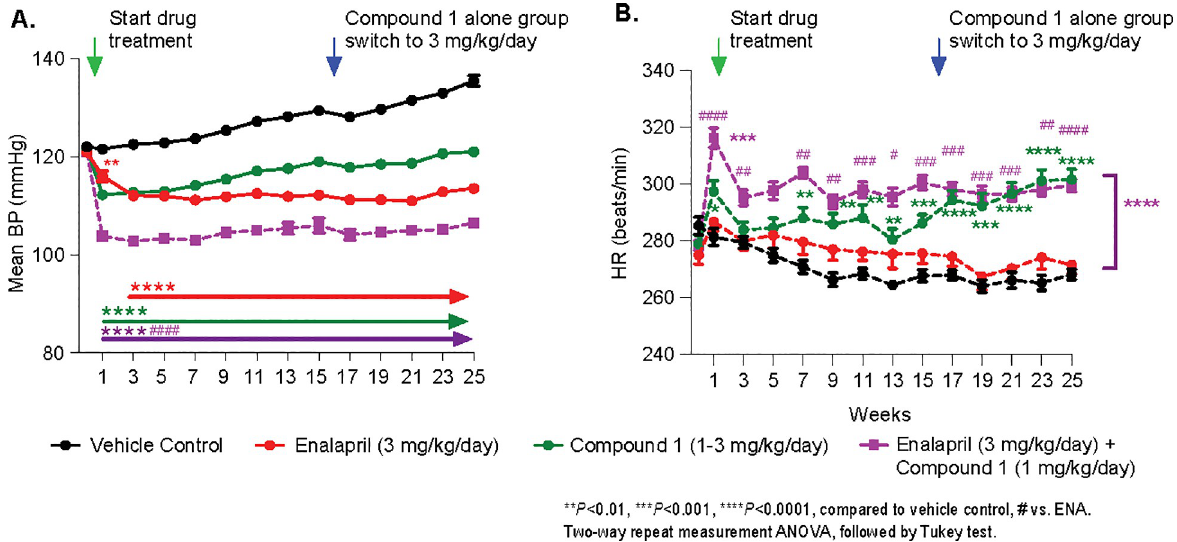
Fig 3. Effect of Compound 1 or Enalapril or combination of Compound 1 and Enalapril on MBP and HR. Green arrow indicates start of the treatments of Vehicle or Compound 1 or Enalapril or combination of Compound 1 and Enalapril for 6 months. Blue arrow indicates Compound 1 dose was switched from 1 mg/kg/day to 3 mg/kg/day. (A) Compound 1 significantly reduced MBP but not as much as Enalapril treatment, while a Compound 1 and Enalapril combination reduced MBP to normotensive level. (B) HR was significantly increased in both Compound 1-treated group and combination-treated groups. Two-way repeated measures ANOVA with multiple comparisons followed by Tukey test.